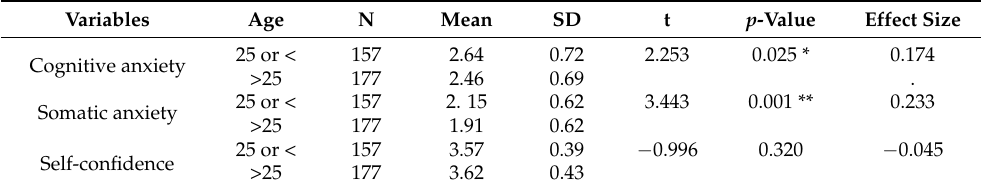
Table 4. Differences between athletes 26 years old or older and 25 years old or younger.